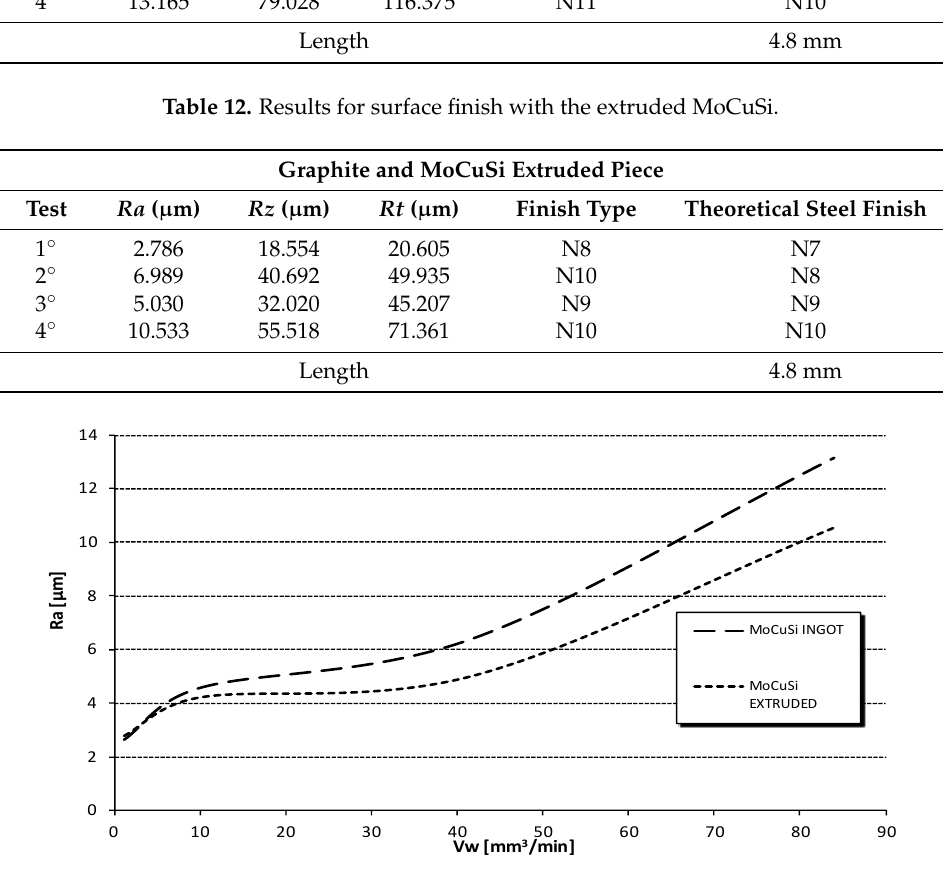
Figure 6. Surface finish and machining volume for the ingot and extruded MoCuSi. Metals 2018 , 8 , x FOR PEER REVIEW